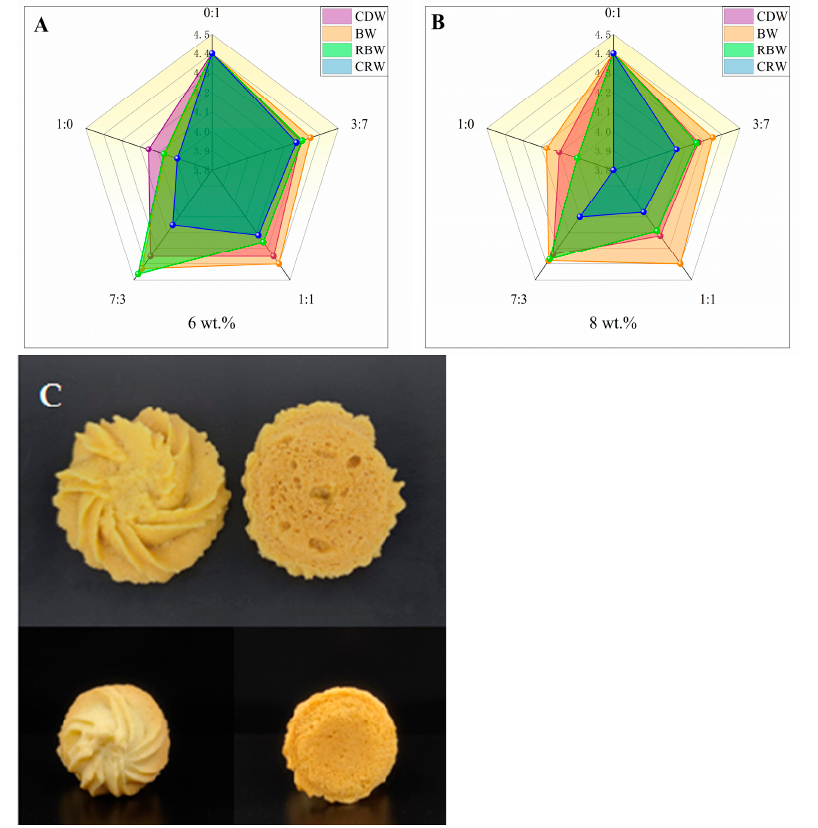
Figure 6. ( A ) Radar plots of the mean values of the total sensory evaluation scores of 6 wt.% CDW oleogel, BW oleogel, RBW oleogel, and CRW oleogel as shortening substitutes for the preparation of cookies at different substitution ratios were represented; ( B ) radar plots of the mean values of the total sensory evaluation scores of 8 wt.% CDW oleogel, BW oleogel, RBW oleogel, and CRW oleogel as shortening substitutes for the preparation of cookies at different substitution ratios were represented; ( C ) visual representation of shortening cookies (the picture above); visual representation of cookies with RBW-6 oleogel at 7:3 replacement shortening (the picture below). Table 2. Sensory parameters of cookies prepared using CDW, BW, RBW, and CRW oleogels at critical concentration and 8 wt.% in different proportions of shortening replacement after evaluation by 20 evaluators (25 °C). a,b,c,d represents the significant difference in sensory evaluation of different samples.